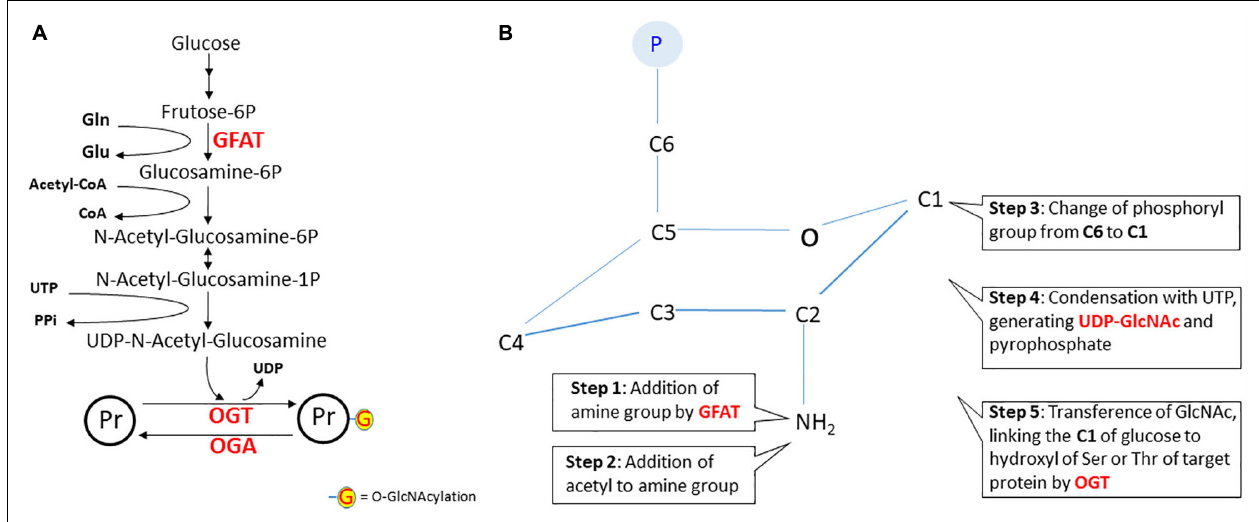
FIGURE 5 | The hexosamine pathway. In panel A , the steps of the hexosamine pathway (HP) from frutose-6P to UDP- N -acetyl-glucosamine. Notice that glutamine (Gln), Acetyl-CoA and UTP are key substrates in this pathway. The rate-limiting step is catalyzed by glutamine:fructose-6P aminotransferase (GFAT). In panel B , a schematic representation of the structural changes during N -acetyl-glucosamine synthesis. The first reaction is the amination of fructose-6P (fructofuranose) to glucosamine-6P (glucopyranose). It is worth noting that, in step six, carbon 1 of glucopyranose binds to the hydroxyl of serine or threonine of the protein target. In fact, this is a reaction of O -linked β - N -acetylglucosaminylation, but for simplification, the nomenclature widely used is O-GlcNAcylation. However, this gives the wrong idea that linking occurs at the acyl group. It would be better to use NAGylation, since NAG is another (and the simplest) abbreviation of N -AcetylGlucosamine, found in some polymers. Herein, we will maintain the use of the term “O-GlcNAcylation.” Abbreviations: OGT, O-GlcNAc transferase; OGA, O-GlcNAcase; Pr,